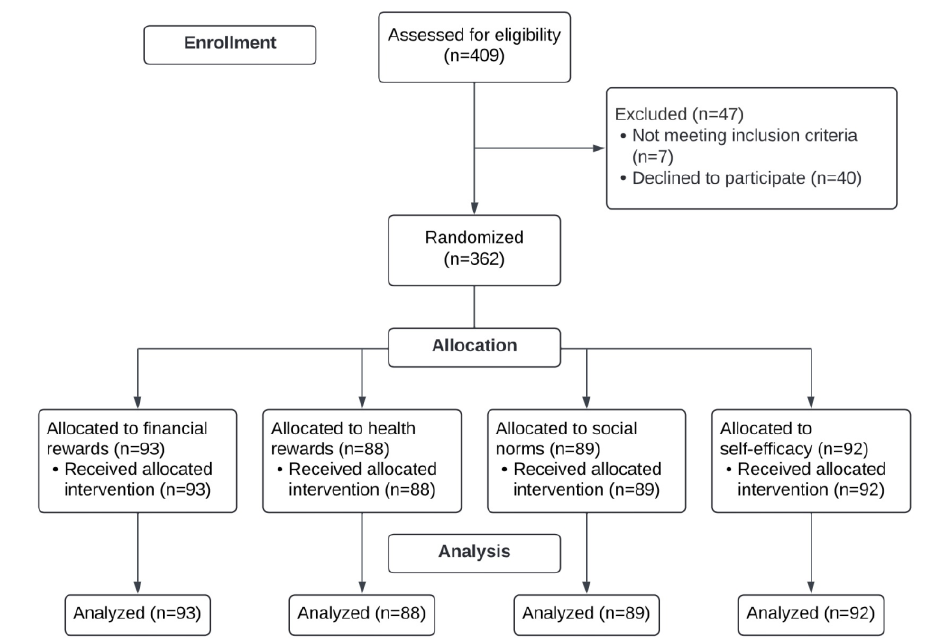
Figure 1. CONSORT flow diagram.